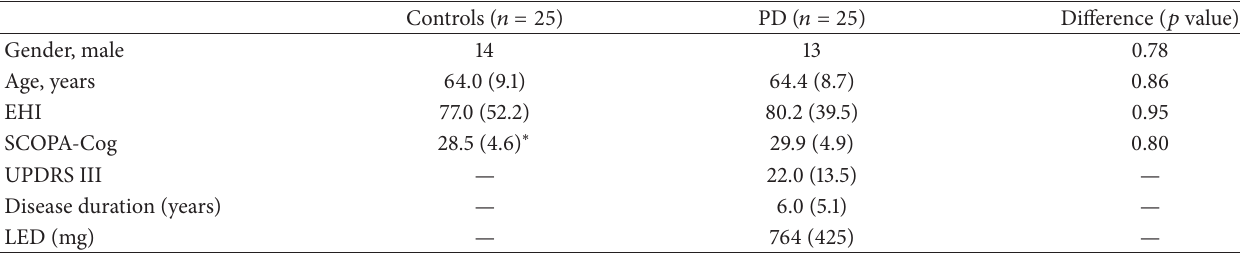
Table 1: Subject